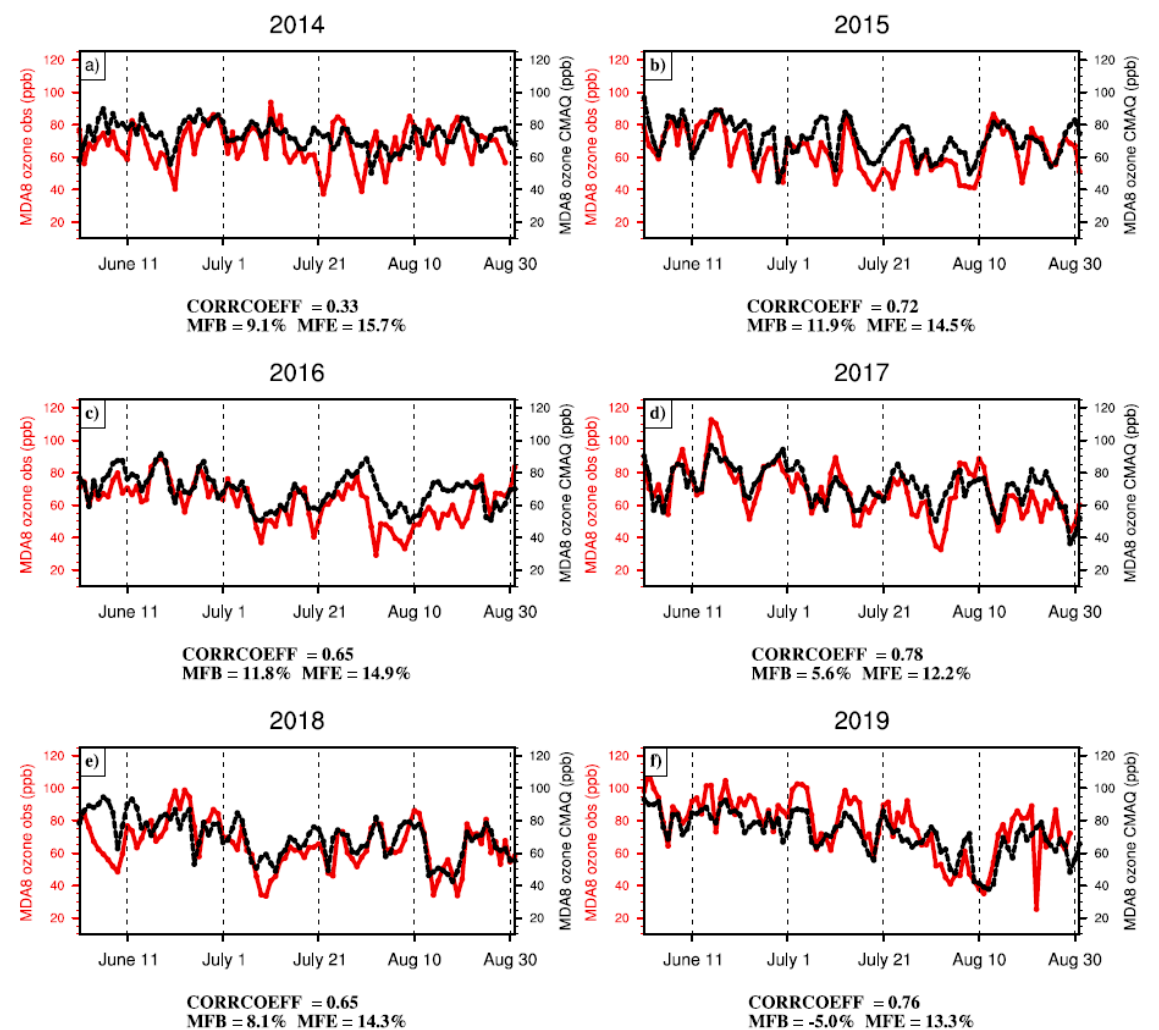
Figure 5. Comparison of MDA8 ozone concentrations over Shandong Province in each summer. Panels ( a – f ) show the MDA8 ozone concentrations from 2014 to 2019. The red and black lines denote observations and the CTRL simulation, respectively. CORRCOEFF, MFB, and MFE represent the correlation coefficient, mean fractional bias, and mean fractional error, respectively.